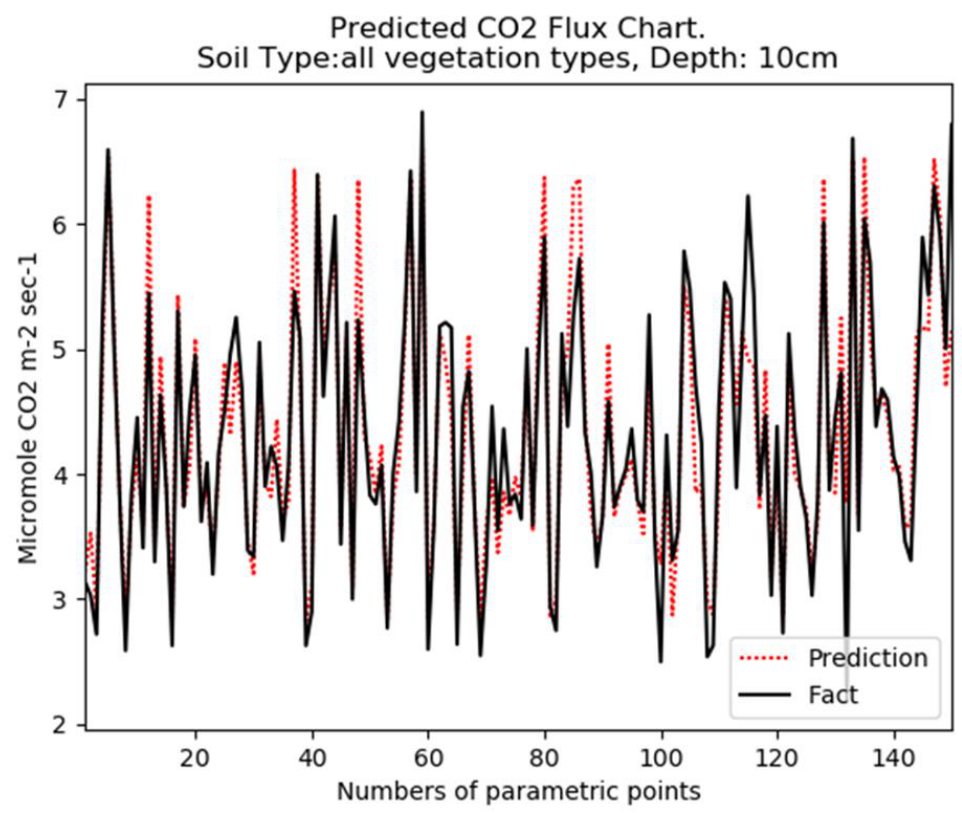
Figure 6. Regression approximation results in experiment 5.